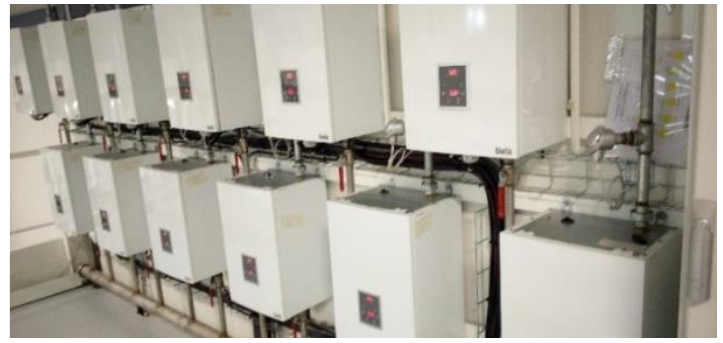
Figure 8. Electrical boilers.